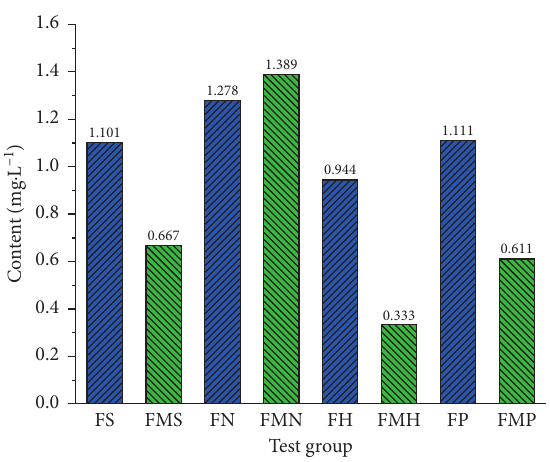
Figure 2: Content of fulvic